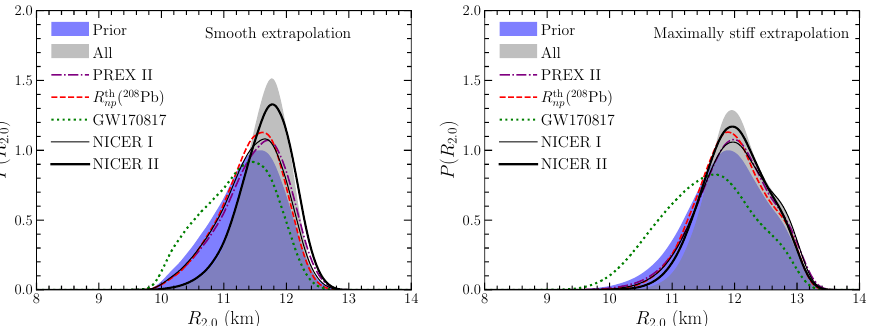
Figure 5. The R 2.0 probability densities (priors, individual posteriors, and combined posteriors) from the smooth high-density extrapolation ( left ) and the maximally-stiff high-density extrapolation ( right ) energy density